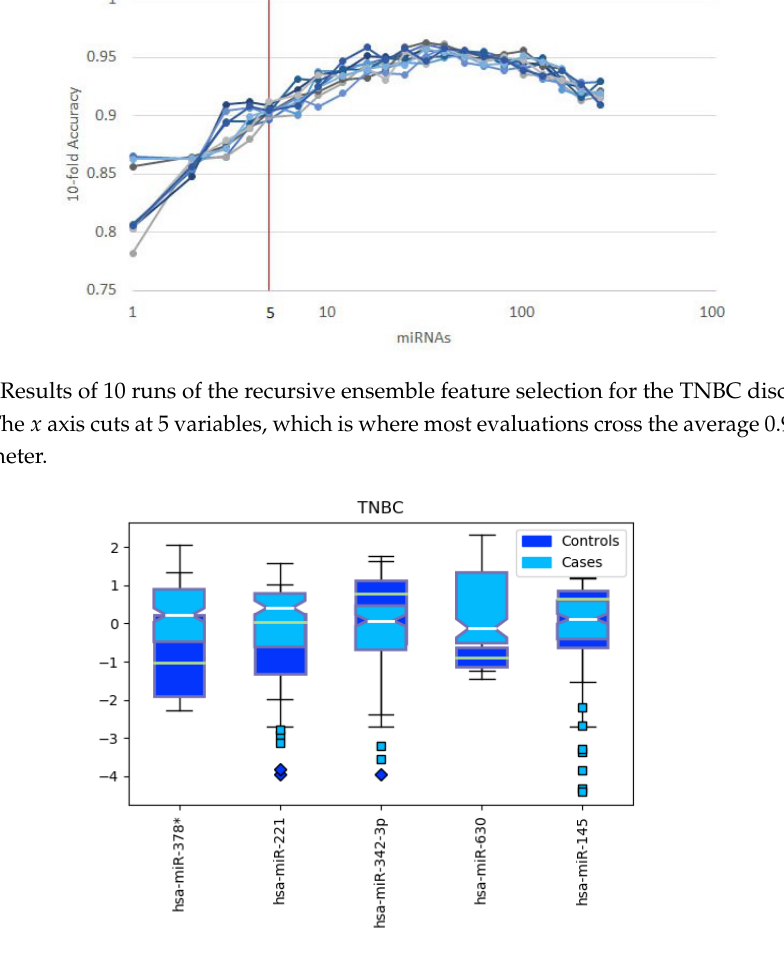
Figure 11. Boxplot for the expression levels between Triple Negative Breast Cancer (TNBC, cases) and other subtypes